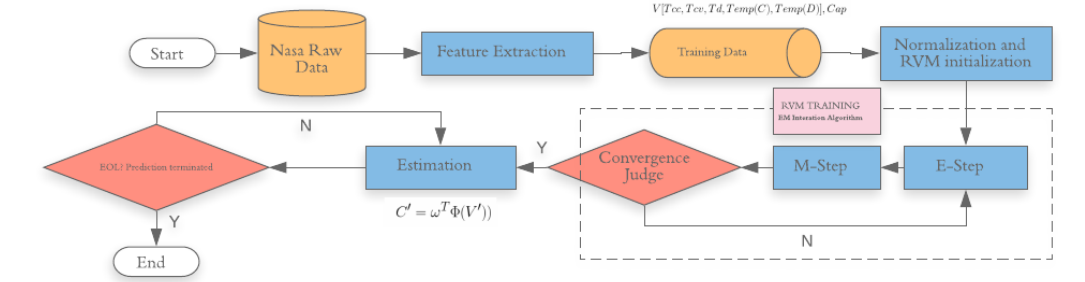
Figure 3. Workflow of the remaining useful life (RUL) estimation